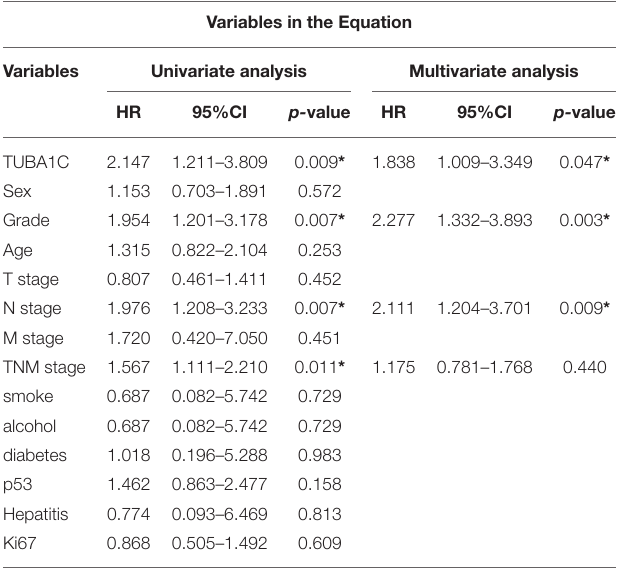
TABLE 3 | Univariate and multivariate analyses of the factors correlated with Overall survival of Pancreatic carcinoma patients.